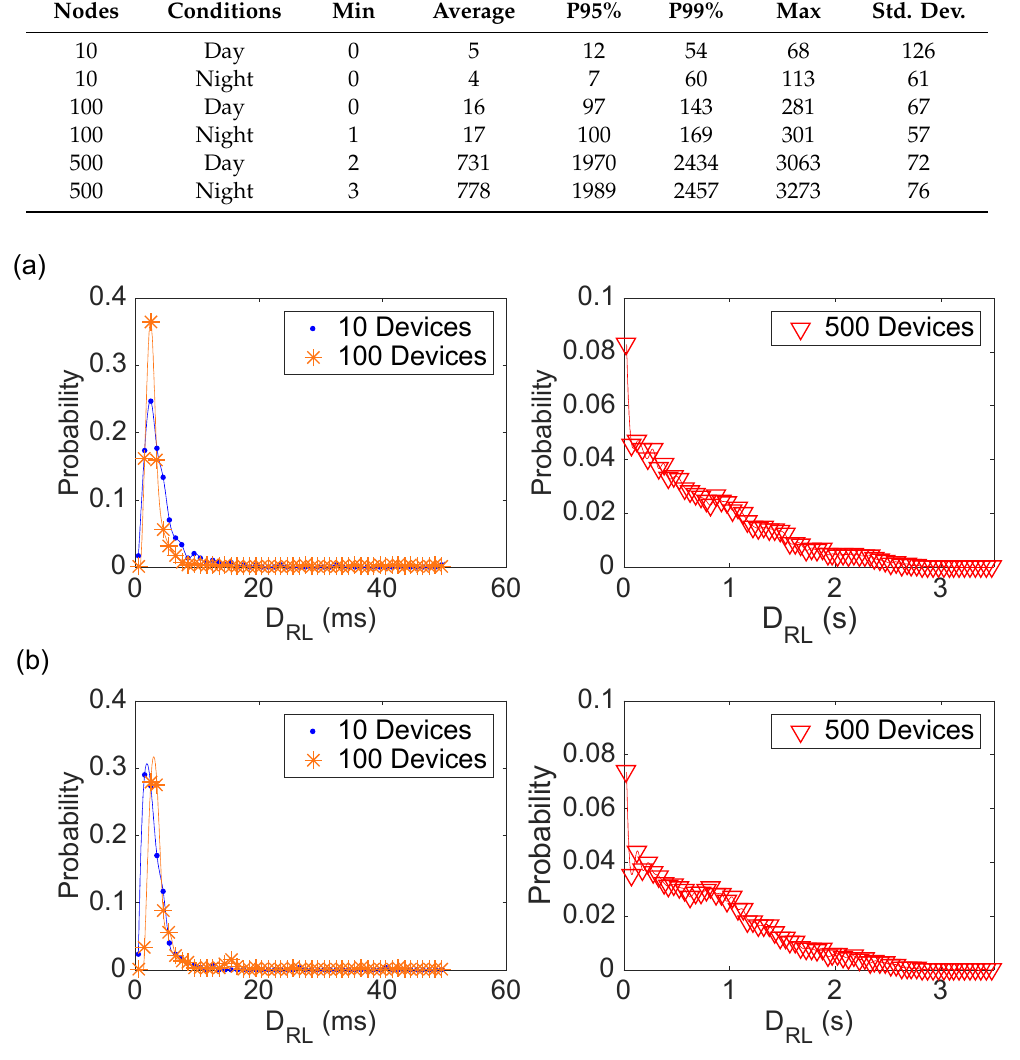
Figure 7. Distribution of the D RL metric varying the number of devices and the moment of the day: ( a ) during the day; ( b ) during the night. Table 7. Statistics of the D RL (delay introduced by the rate limiter block) collected in the scalability experiments. All values are in milliseconds.